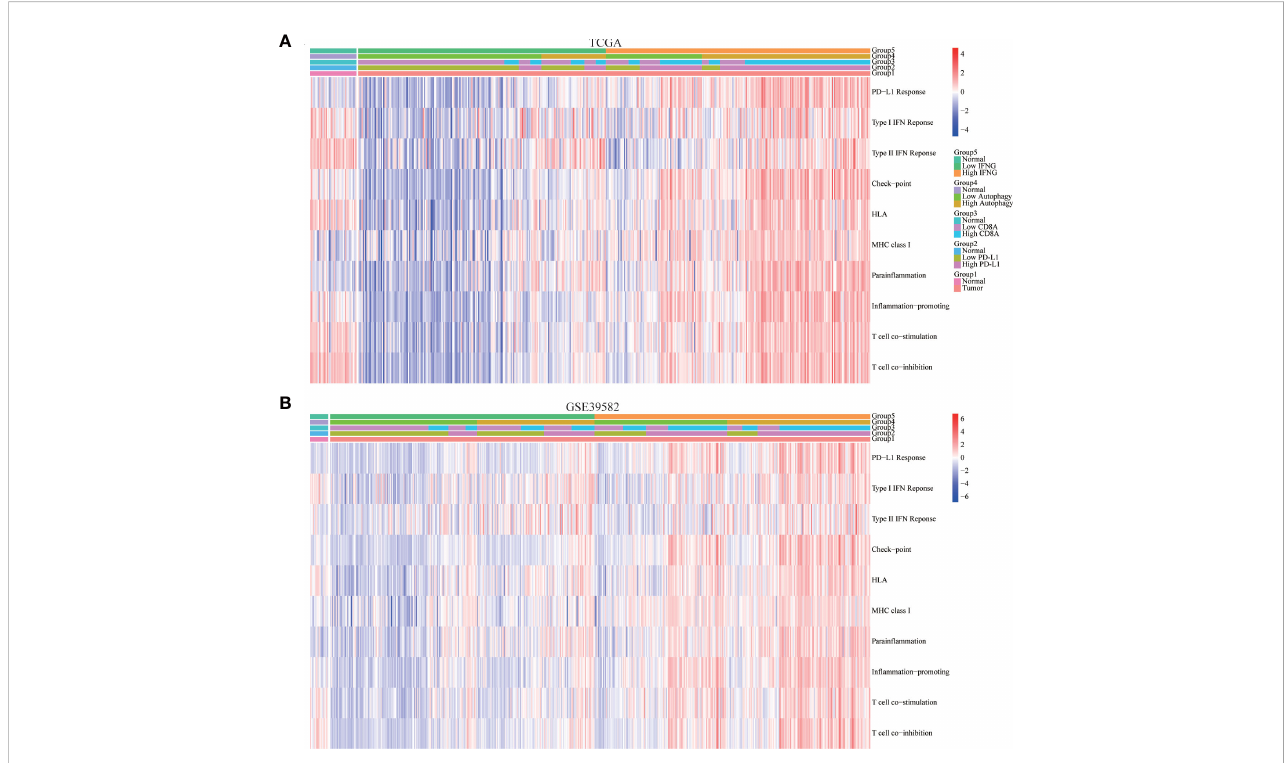
FIGURE 9 Correlation of immune signatures. In (A) TCGA and (B) GSE39582, the score of most immune signatures in the high IFNG group and high autophagy score group were signi fi cantly